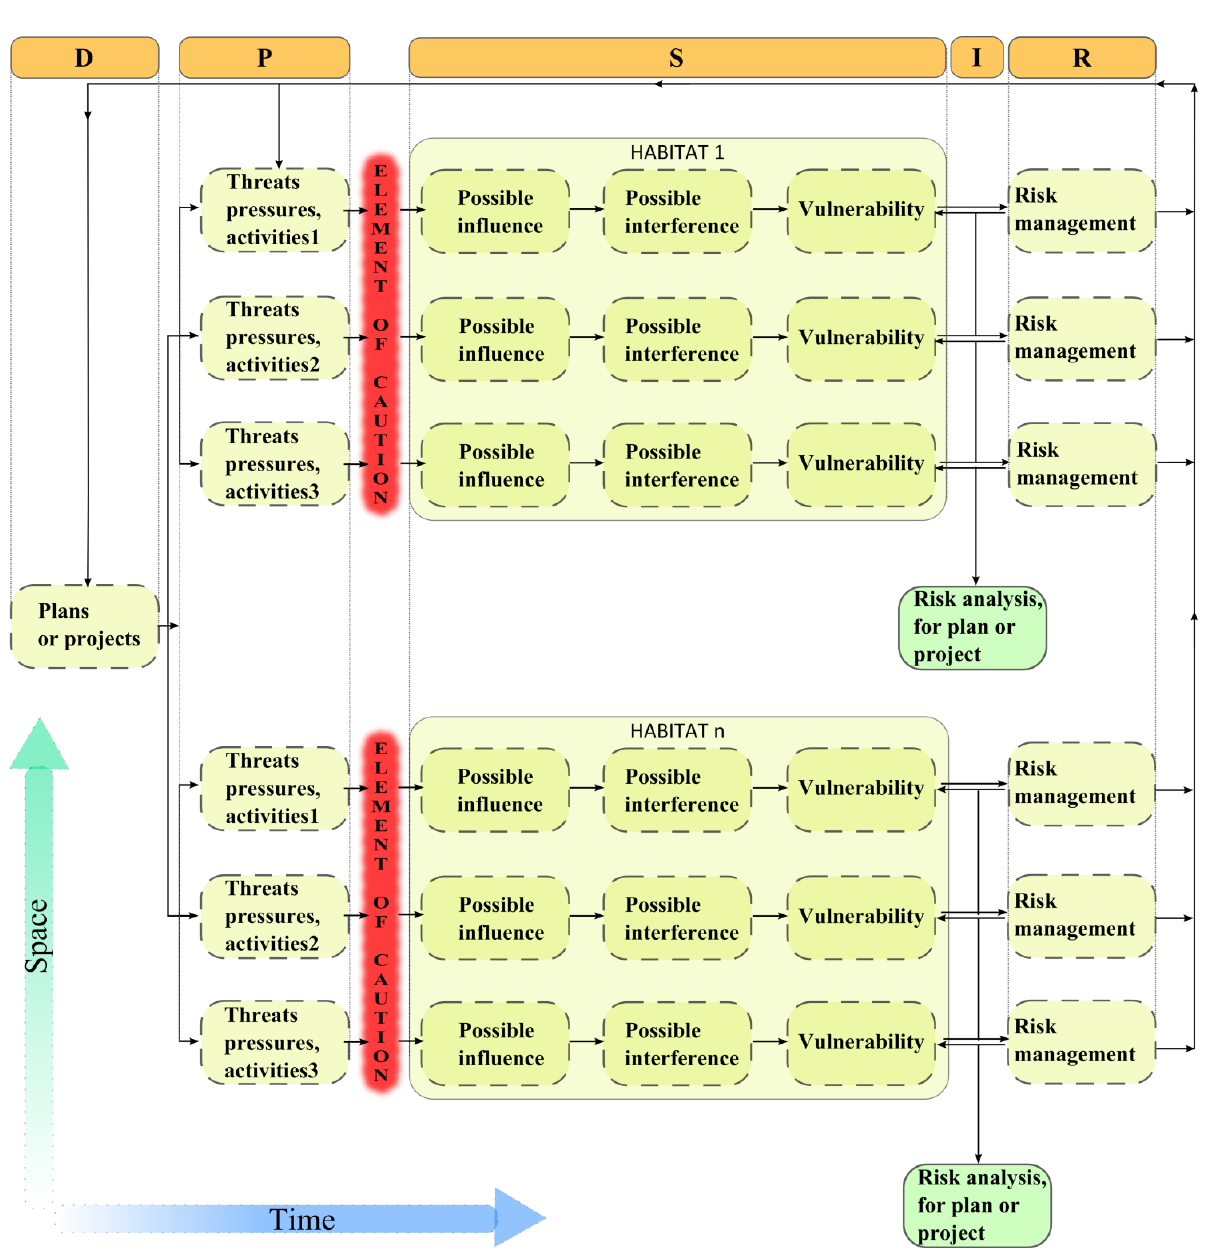
Figure 3. Multidimensional analysis by application of ecological risk assessment in the DPSIR